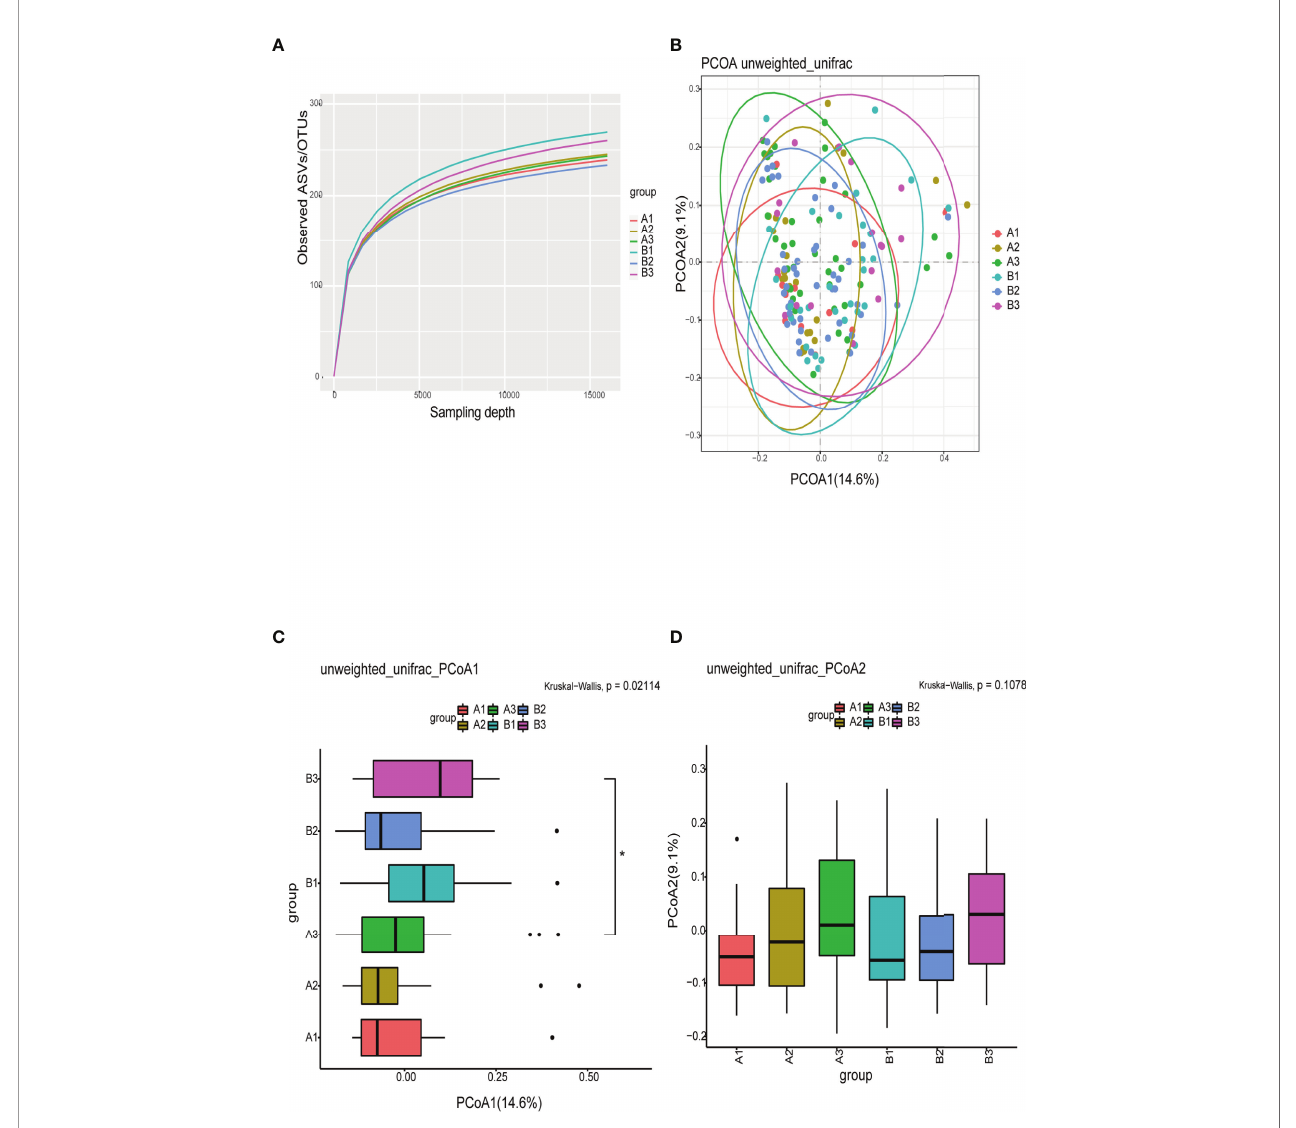
FIGURE 3 | (A) Refraction curves based on random extraction of sequencing data from fecal samples from the six subgroups. (B – D) b -diversity analysis conducted with the unweighted unifrac algorithm. Ellipses represent 95% con fi dence intervals for each subgroup in Figure 3B . * P <0.05. A1, TPOAb-positive women with SCH and no LT 4 ; A2, TPOAb-positive women with SCH and low-dose LT 4 ; A3, TPOAb-positive women with SCH and high-dose LT 4 ; B1, TPOAb-negative women with SCH and no LT 4 ; B2, TPOAb-negative women with SCH and low-dose LT 4 ; B3, TPOAb-negative women with SCH and high-dose LT 4